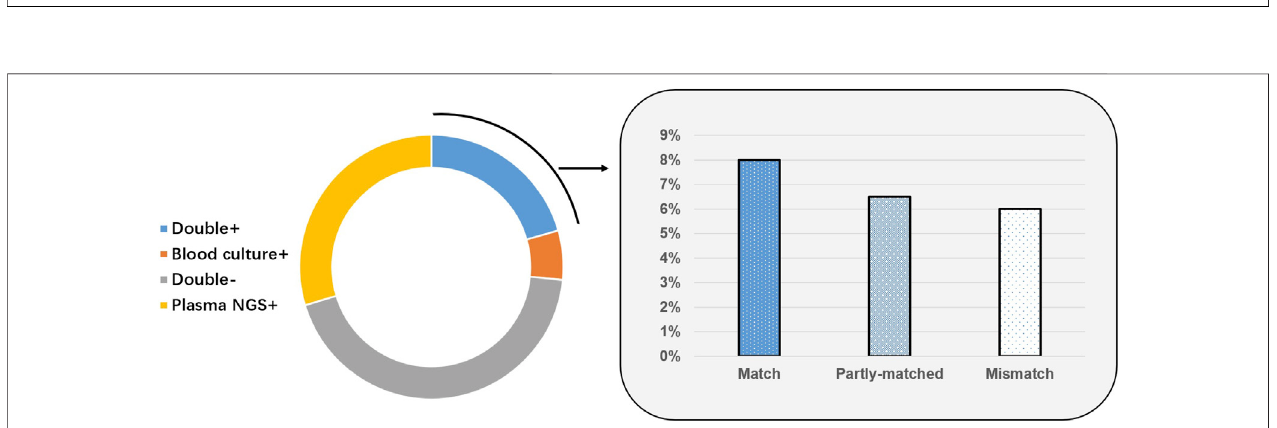
Frontiers in Molecular Biosciences |